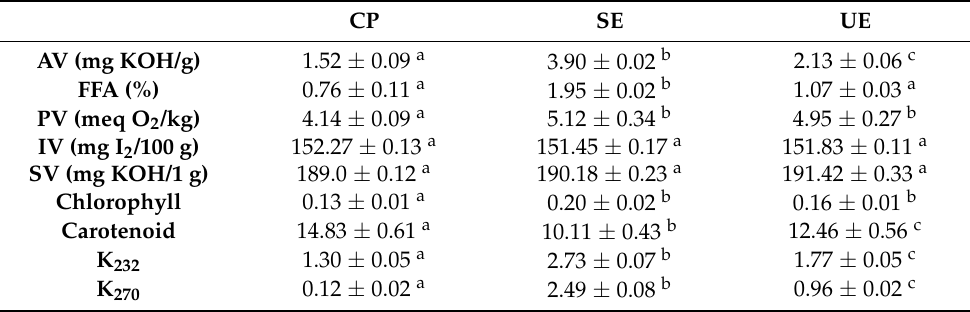
Table 1. Physicochemical properties, and chlorophyll and carotenoid content of walnut seed oils extracted by different methods (Mean ±